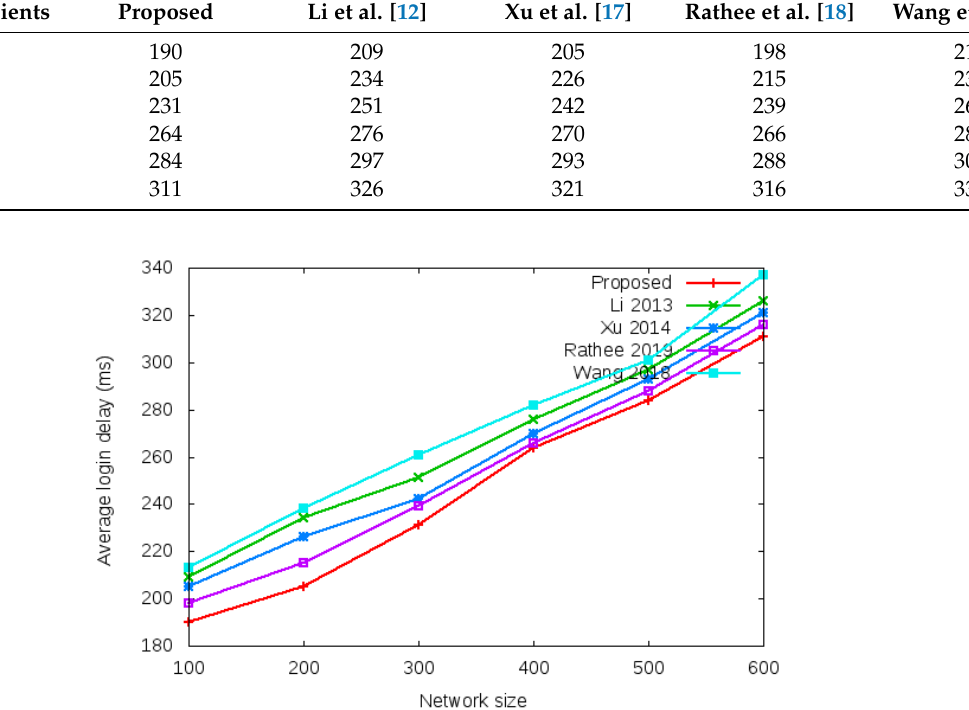
Figure 12. Average login authentication delay.